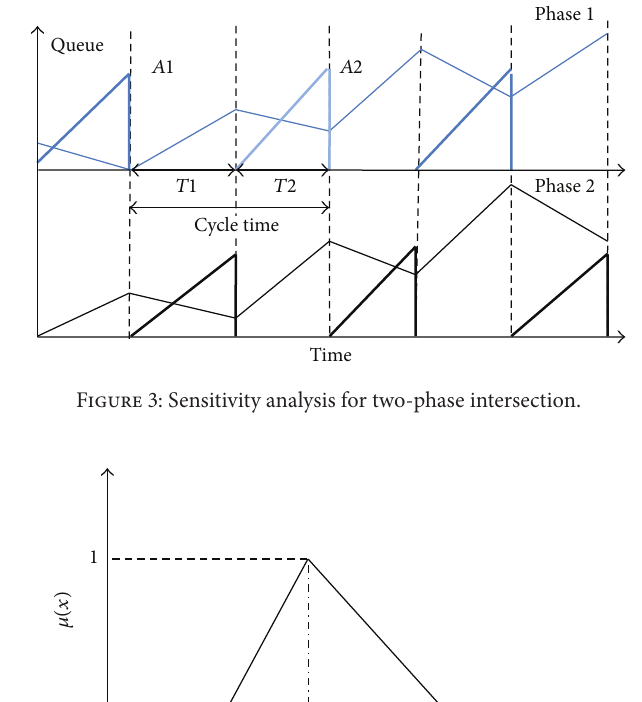
Figure 4: A triangular fuzzy number